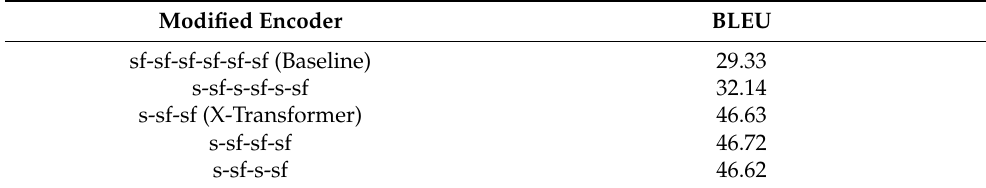
Table 2. BLEU scores on different arrangements of self-attention mechanisms and feed forward layers in the